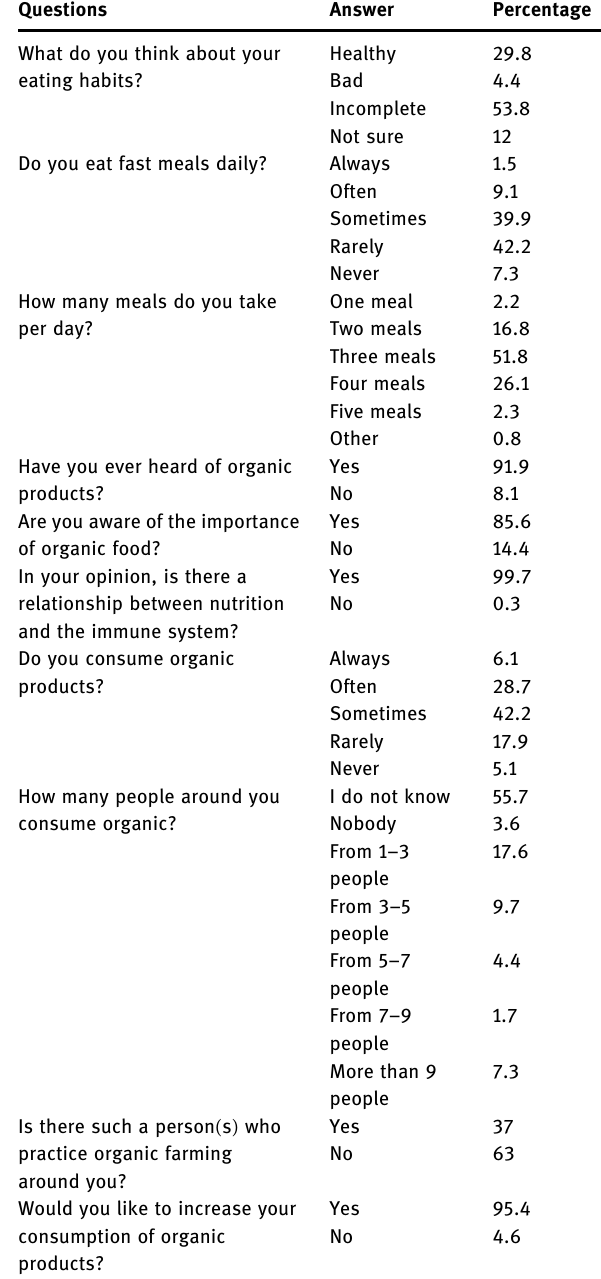
Table 2: Level of consumption of organic products by